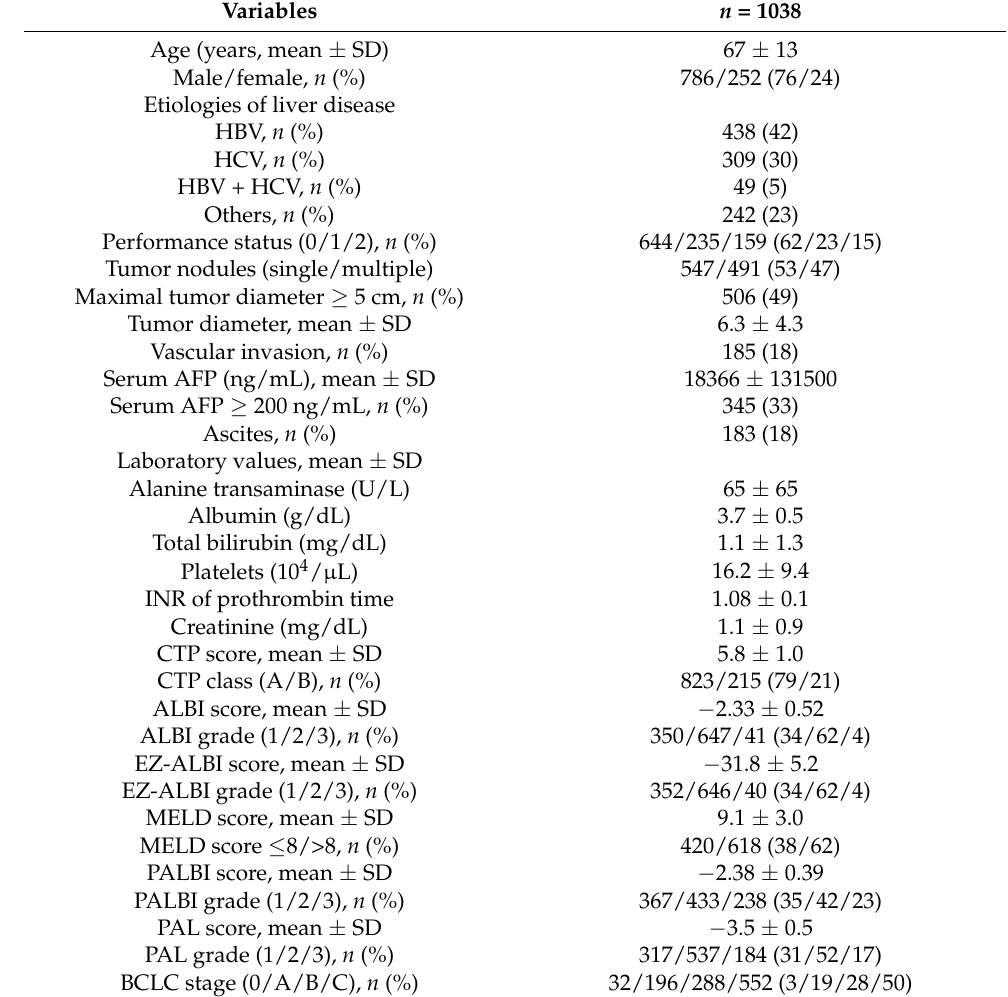
Table 1. Baseline characteristics of HCC patients undergoing transarterial chemoembolization ( n =